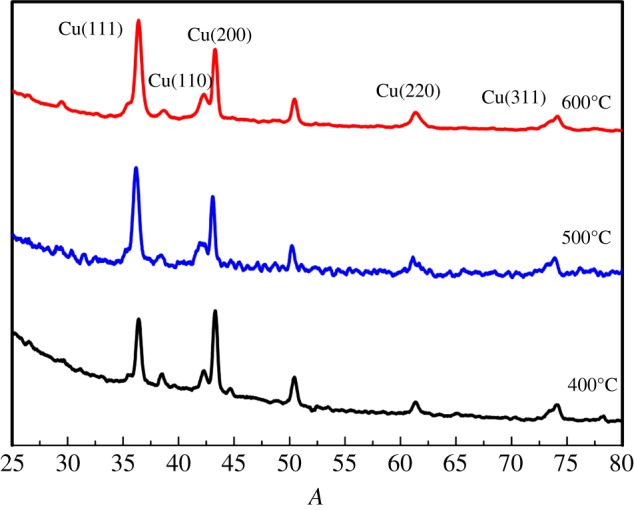
XRD patterns of Cu2O/HCFs. Those were prepared at 400, 500 and 600°C for Cu2O/HCFs.